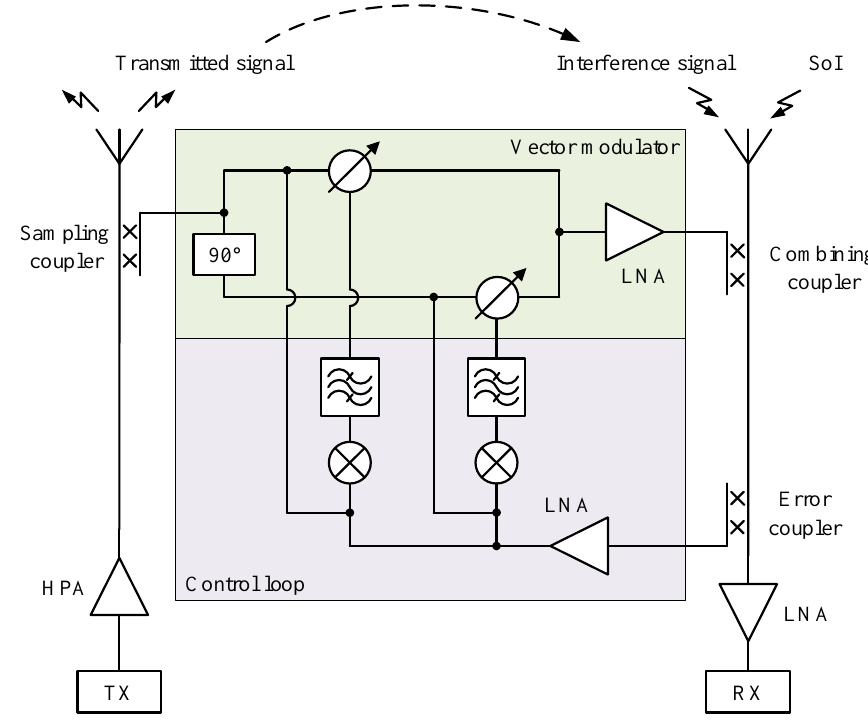
Figure 5. A typical analog SIC